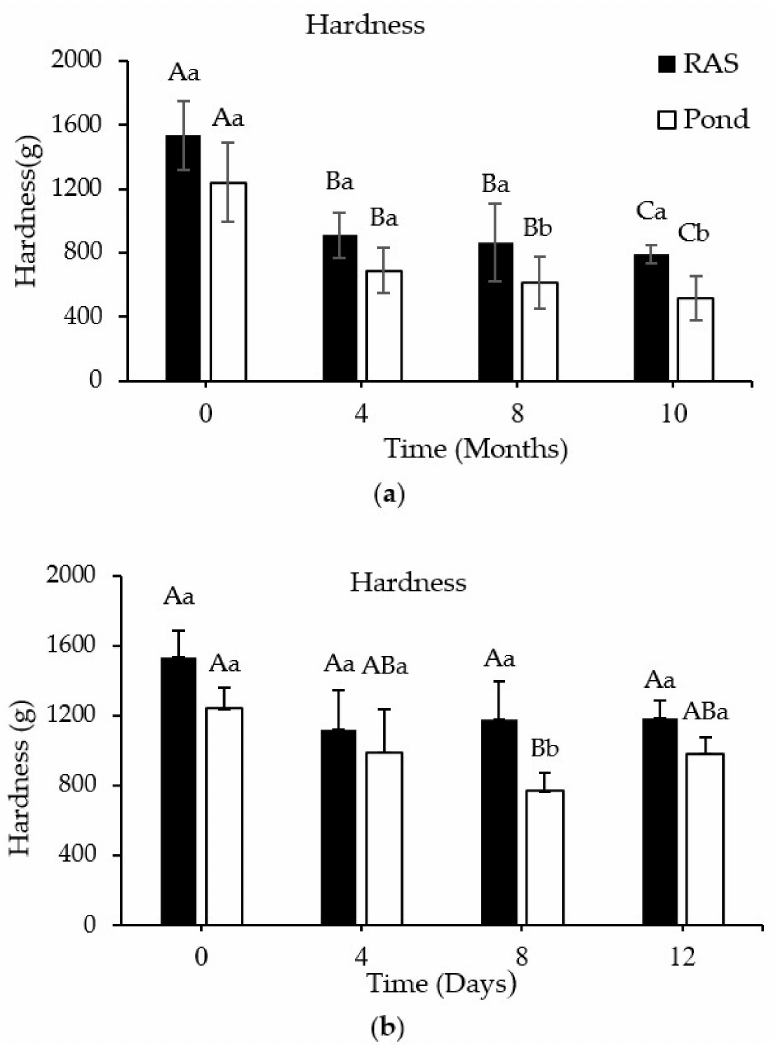
Figure 3. ( a ) Changes in hardness of perch fillets from RAS and pond systems during storage at − 20 ◦ C and ( b ) storage at +4 ◦ C (mean ± S.D., n = 6), respectively. Different capital letters on the bar donate significant differences ( p < 0.05) within each rearing system. Small superscript letters on the bar donate significant differences ( p < 0.05) between rearing systems at the same time